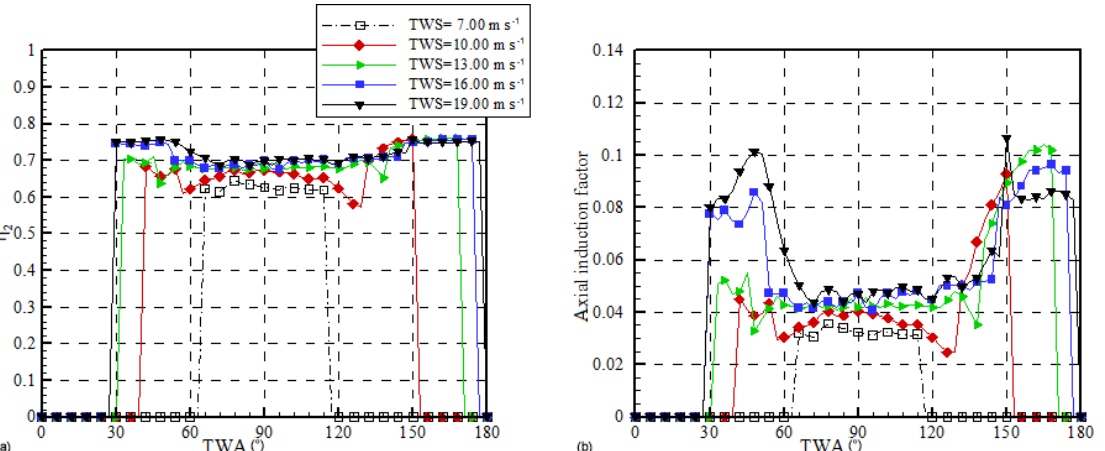
Figure 14. Efficiency of the conversion of wind energy into mechanical energy by the proposed energy ship design (a) and optimal induction factor (b) as a function of the wind conditions. TWS stands for true wind